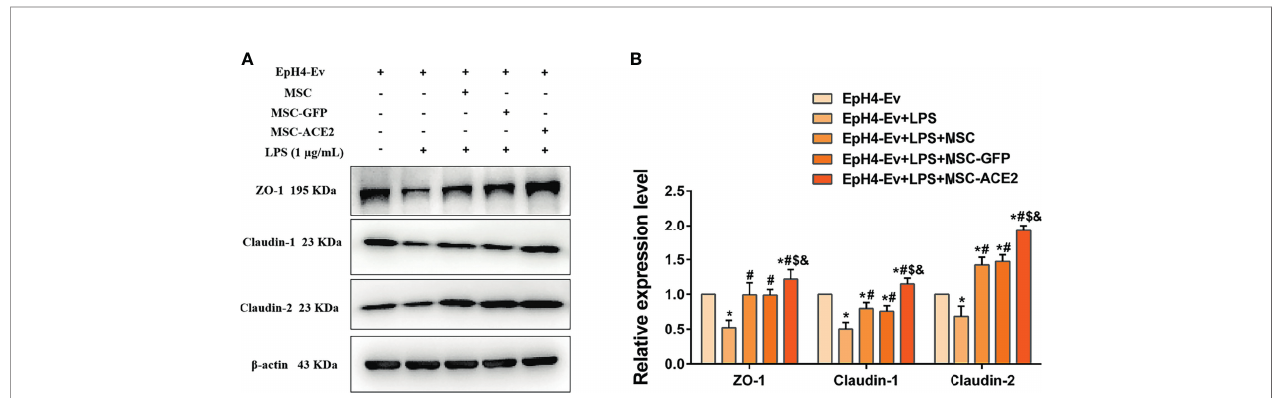
FIGURE 8 | MSC-ACE2 upregulates blood-milk barrier-related protein expression to suppress LPS-induced in fl ammation in Eph4-EV cells. (A) Detection of relative protein expression levels of ZO-1, Claudin-1, Claudin-2 by Western blot; (B) Statistics of the ZO-1, Claudin-1, Claudin-2 Western blot results. Experiments were repeated three times and data were presented as the mean ± SEM (n = 4). * P < 0.05 vs. EpH4-Ev; # P < 0.05 vs. LPS; $ P < 0.05 vs. MSC; & P < 0.05 vs.